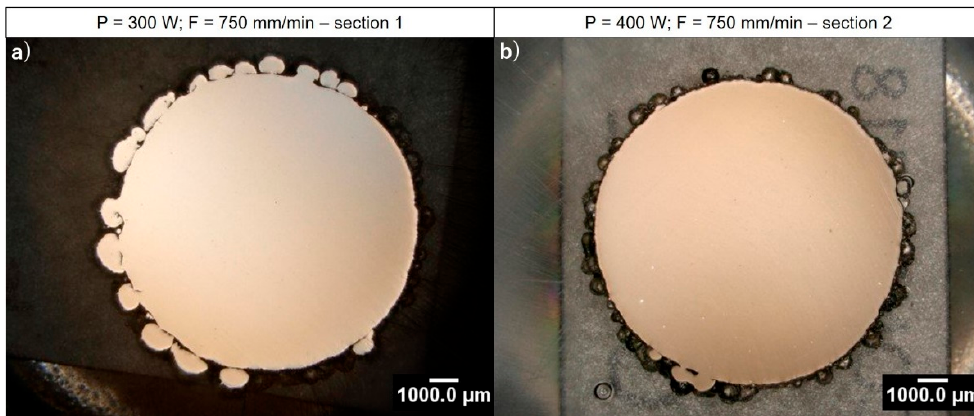
Figure 11. Structural analysis of the as-built cylinders cross-sections through optical microscope: ( a ) cylinder built at P 300 W and F 750 mm/min; ( b ) cylinder built at P 400 W and F 750 mm/min.